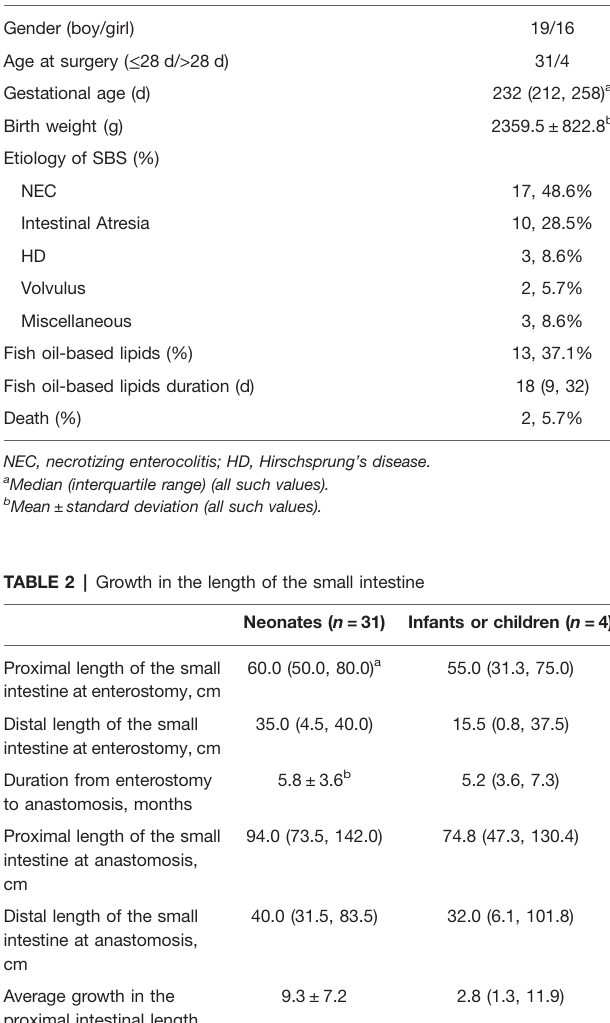
TABLE 1 | Clinical characteristics of the patients